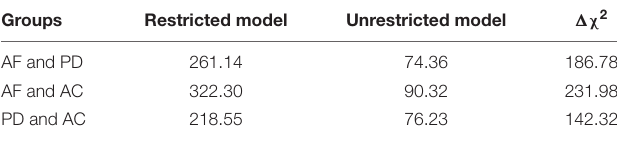
TABLE 2 | A summary of dimension discrimination competition